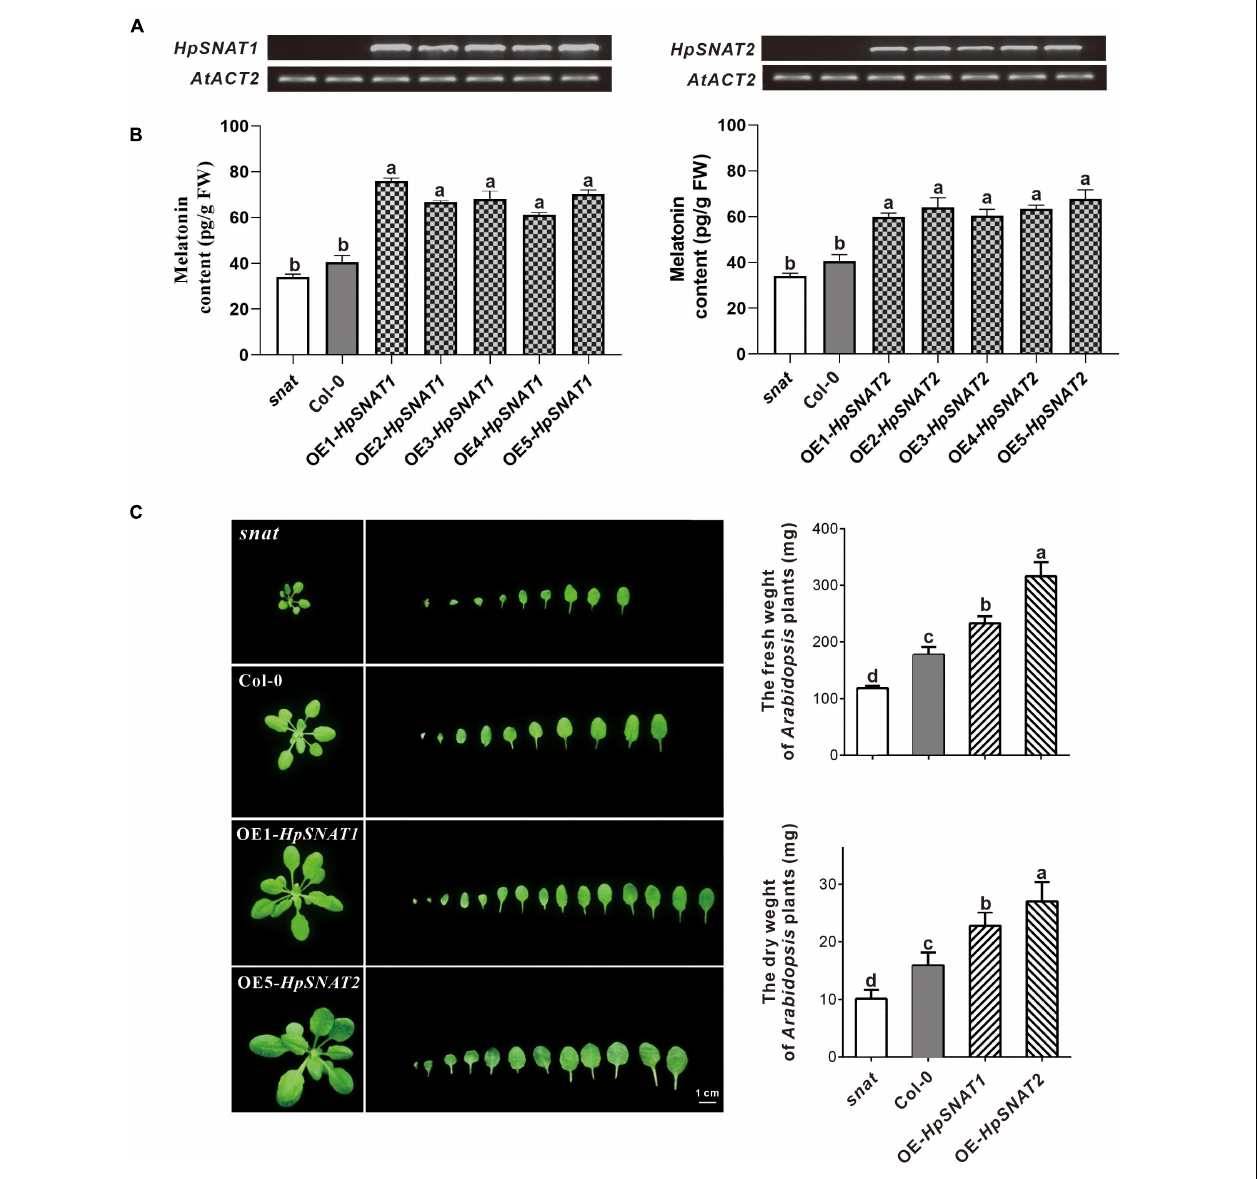
FIGURE 3 | The melatonin content and phenotype of snat , Col-0, and overexpressed Arabidopsis (OE). (A) and (B) Expression levels of HpSNAT and melatonin content in snat , Col-0, and five OE lines. HpSNAT expression was analyzed by RT-PCR. (C) Comparison of the rosette leaves in snat , Col-0, and OE lines. Each value represents the average of three replicates, and the error bars represent ± SD. Different letters indicate significant differences from the control ( P < 0.05) tested by one-way ANOVA.